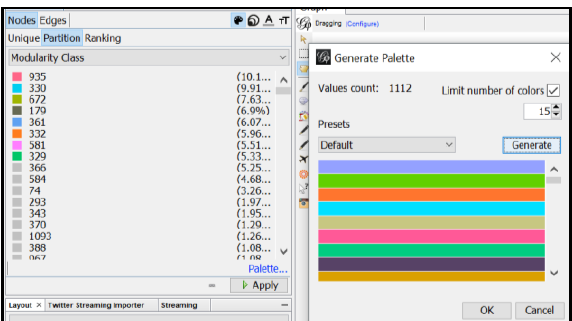
Figure 3. Community Detection in GEPHI